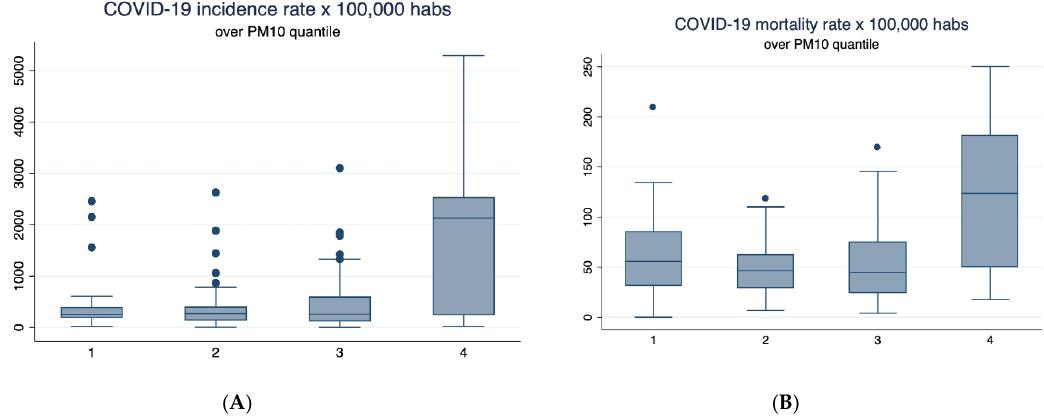
Figure 4. Box plot of COVID-19 incidence and mortality rate above quantile of PM 10 . ( A ) Relationship between quartiles of PM 10 and COVID-19 incidence rate × 100,000. ( B ) Relationship between quartiles of PM 10 and COVID-19 mortality rate × 100,000. The quartiles of PM 10 are 1: [3.43–11.31 μ g/m 3 ); 2: [11.31–18.30 μ g/m 3 ); 3: [18.30–32.61 μ g/m 3 ); 4: [32.61–81.43 μ g/m 3 ]. Maps were made using ArcGIS 10.6 software and the statistical analyses using Stata version 14 statistical software.